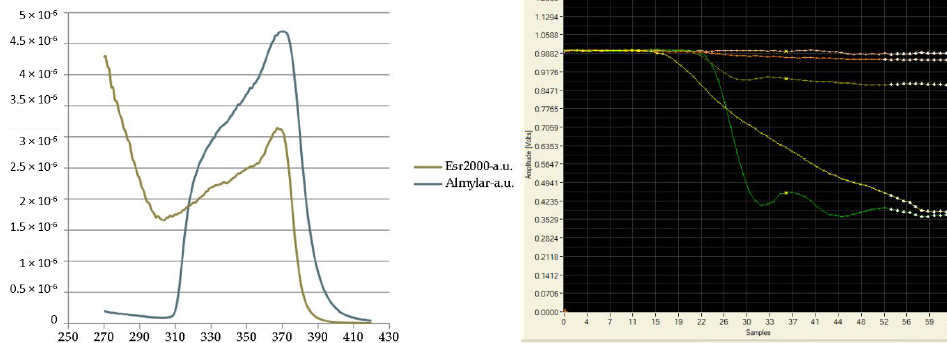
Figure 7. A 440 nm emission spectrum ( left ) and digitized waveform ( right ) of Esr2000 and Al-Mylar films. The sampling rate of the Sampic was set to 6.4